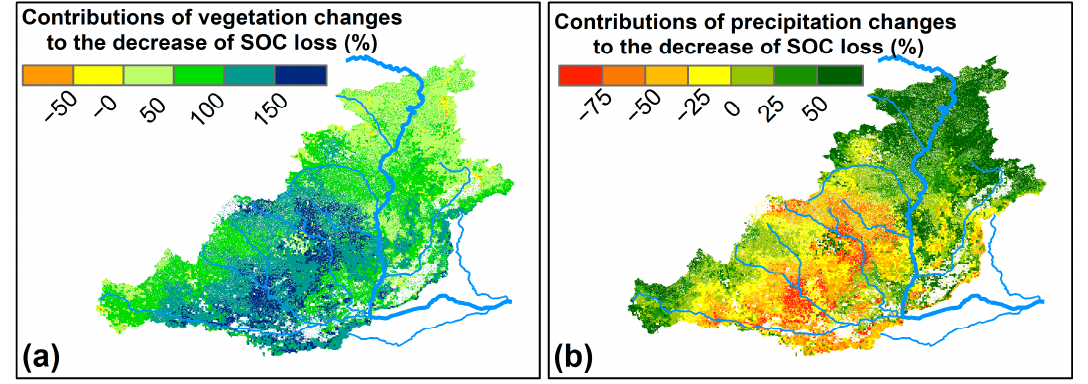
Figure 7. Contributions of ( a ) precipitation and ( b ) vegetation changes to the reduction in SOC loss in regions experienced decreasing SOC loss.